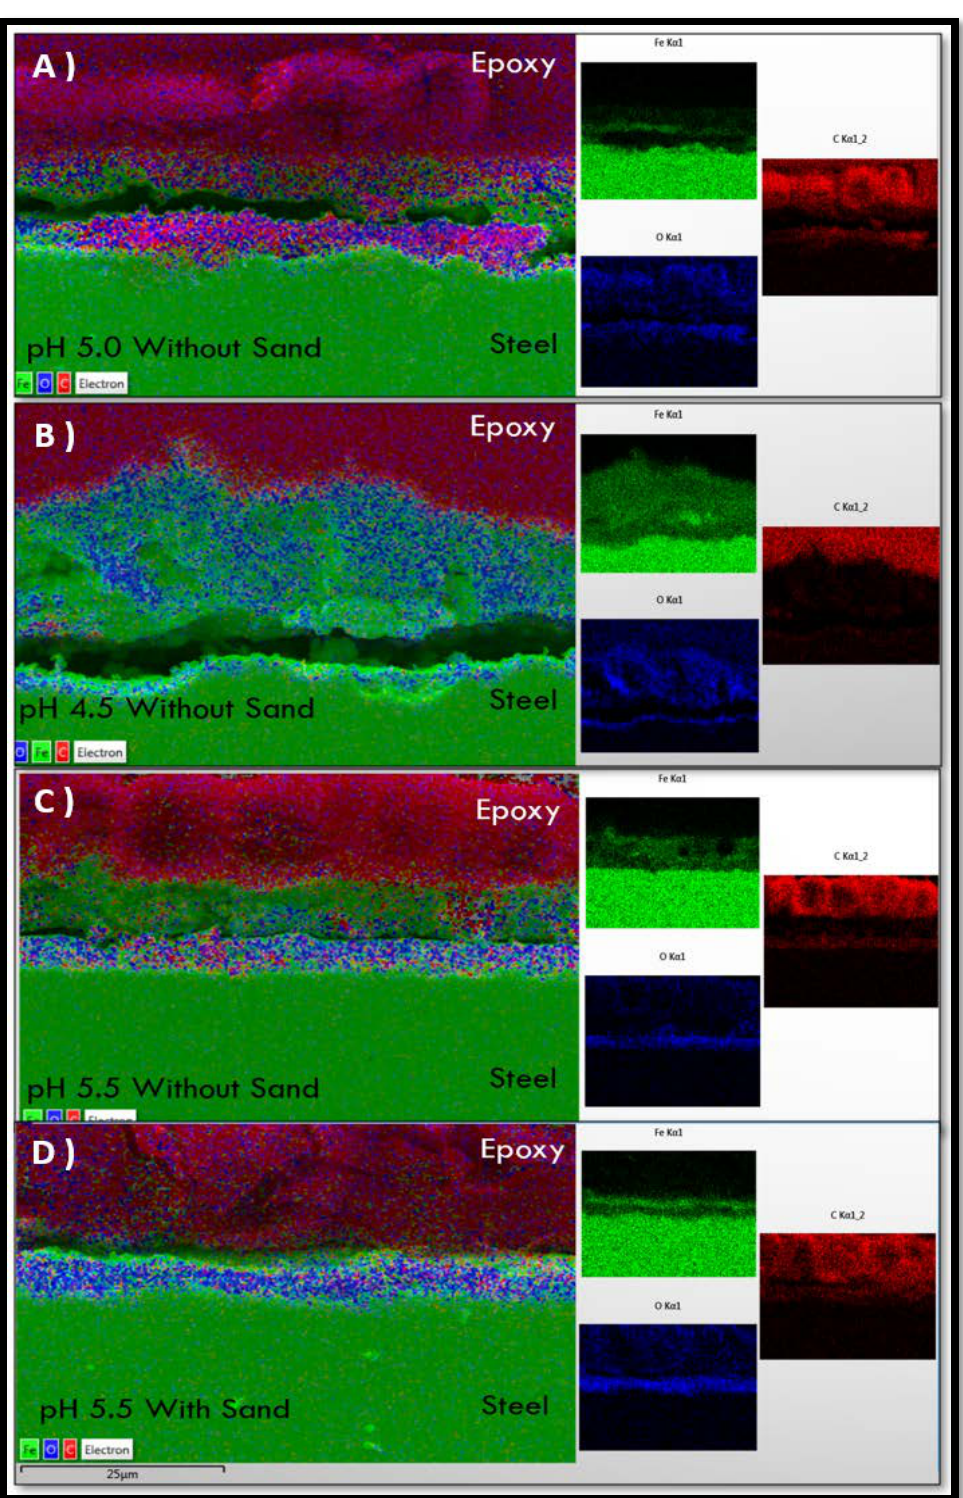
Figure 10. Elemental analysis and distribution for API 5L X65 tested in CO 2 EC at impingement angle 90 ◦ , room temperature, impingement velocity of 8 m / s: ( A ) pH 5.0 without sand, ( B ) pH 4.5 without sand, ( C ) pH 5.5 without sand, and ( D ) pH 5.5 with